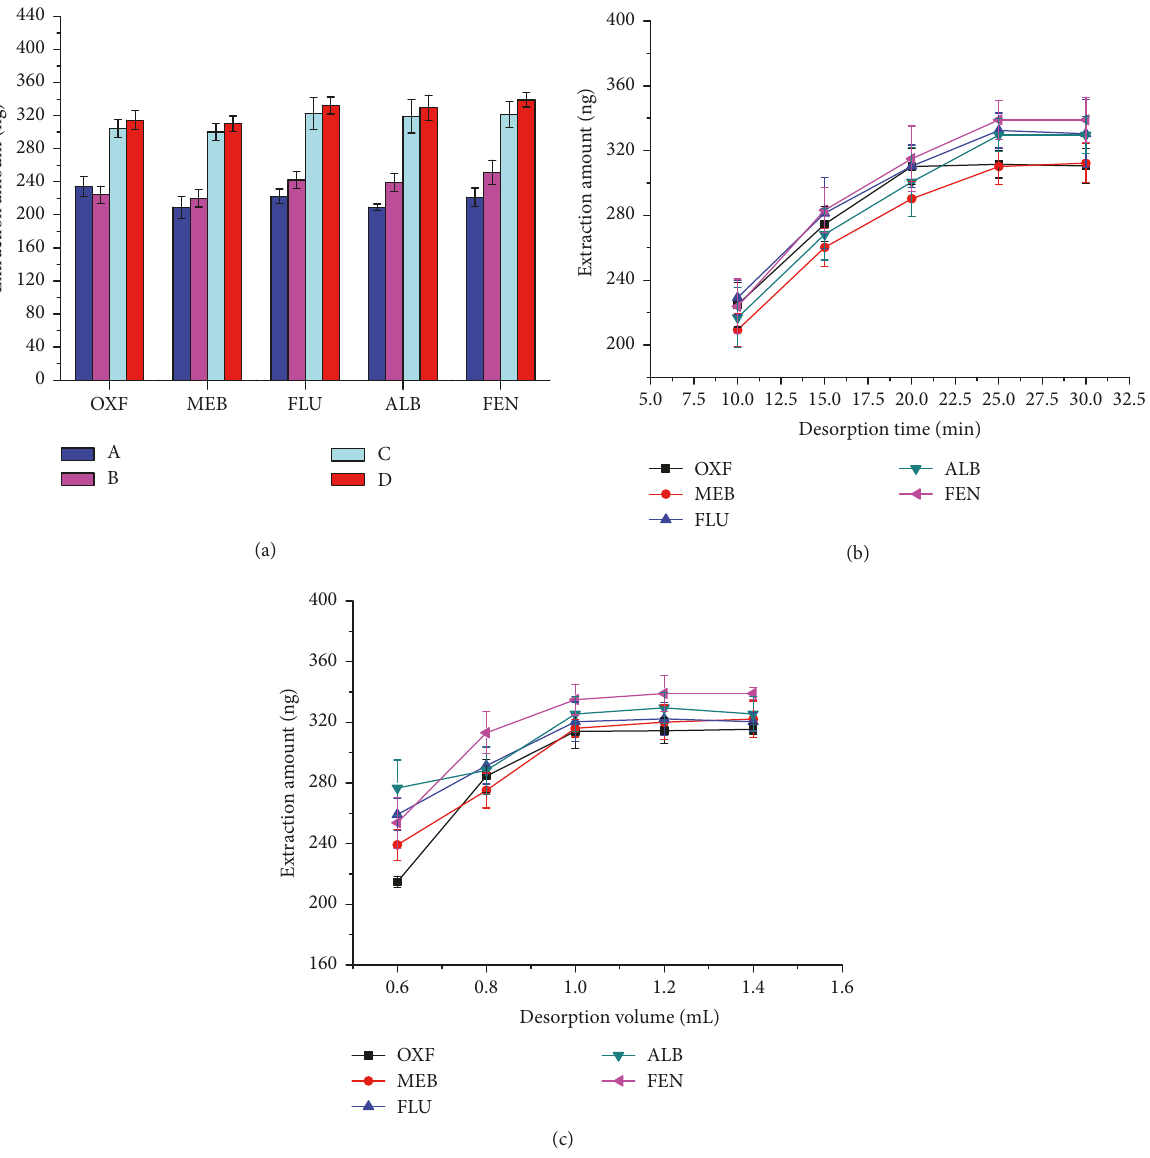
Figure 4: Effects of experimental conditions on the desorption efficiency. (a) Effects of desorption solvent, A: acetonitrile; B: methanol; C: acetic acid/acetonitrile (1: 99, v/v); D: acetic acid/methanol (1: 99, v/v); (b) desorption time; and (c) volume of desorption